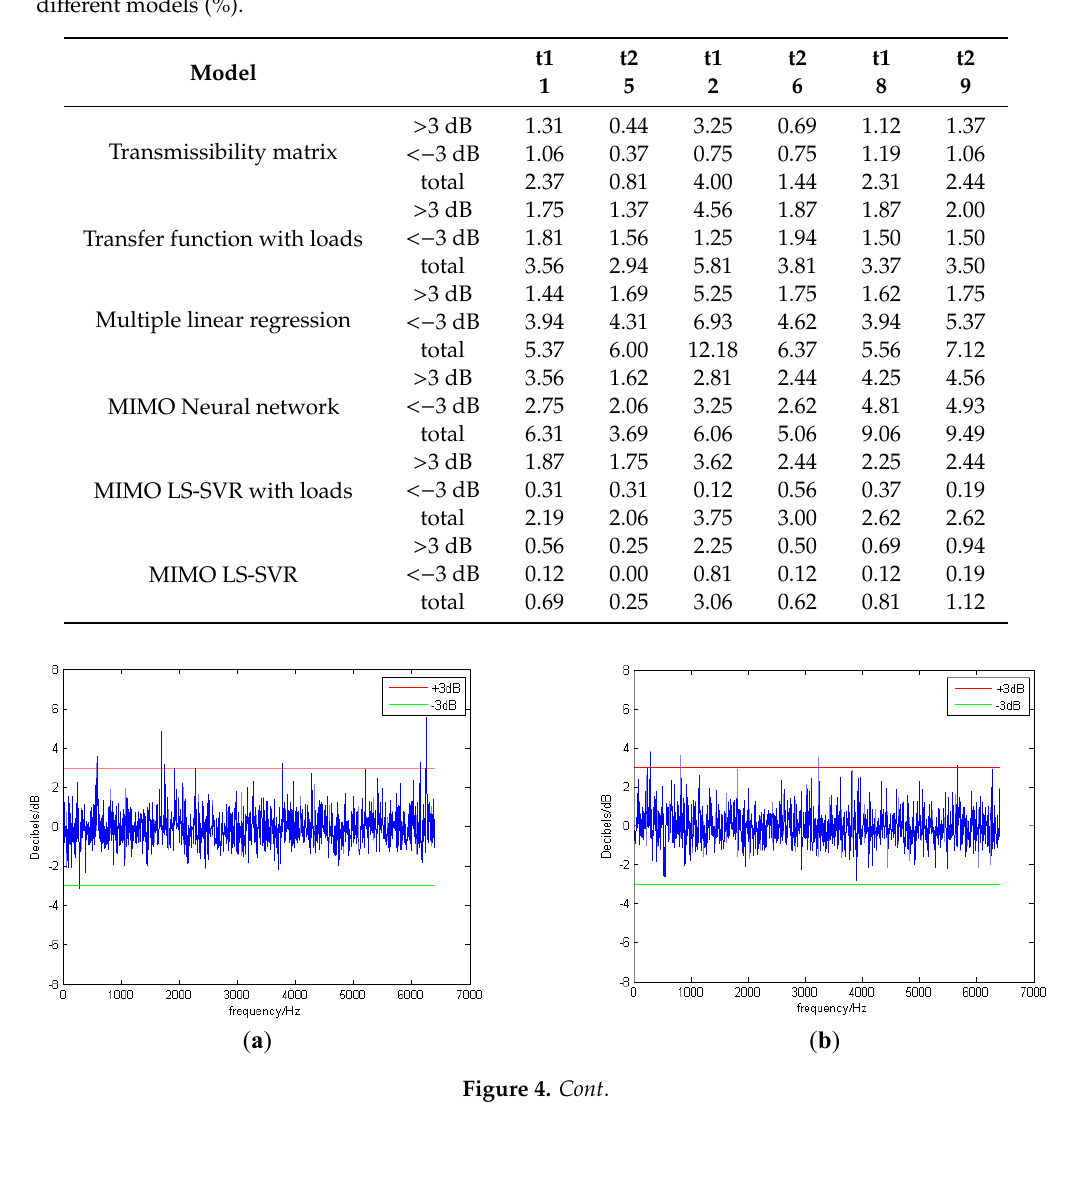
Table 2. Percentage of the number of frequencies whose energy prediction error is over 3 dB for di ff erent models (%).